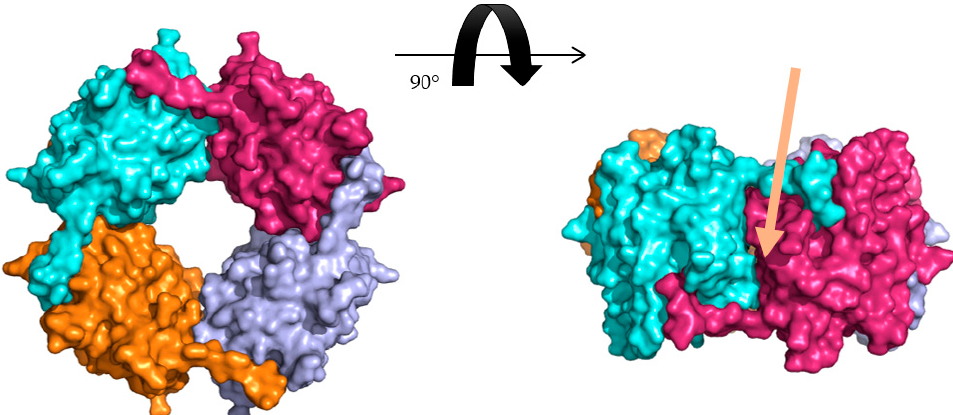
Figure 2. Octameric assembly of hoefavidin. Surface representation of the octameric assembly of wild type apo hoefavidin (PDB code 4Z6J) as observed in the crystalline state where each of the dimers are shown in cyan, purple, light blue and orange. The C-terminal segment of each monomer penetrates to the biotin binding site of its adjacent non-canonical dimer contributing to the stability of the assembly. The right panel is rotated by 90 ◦ along the horizontal axis exemplifying the non-canonical interface and the role of the c-term region, with the interface indicated by the arrow.